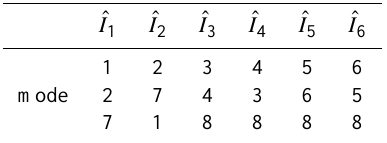
Fig. 7. w correlation, (a) for the whole components for L SSA = 100 Fig. 7. w-correlation, (a) for the whole components for L SSA = 100 and (b) for the first 8 components. and (b) for the first 8 components. Table 2. Relationship of modes between the 1st and 8th eigentriples by w correlation. ˆ I i ( i = 1 , ··· , 6): group indices.